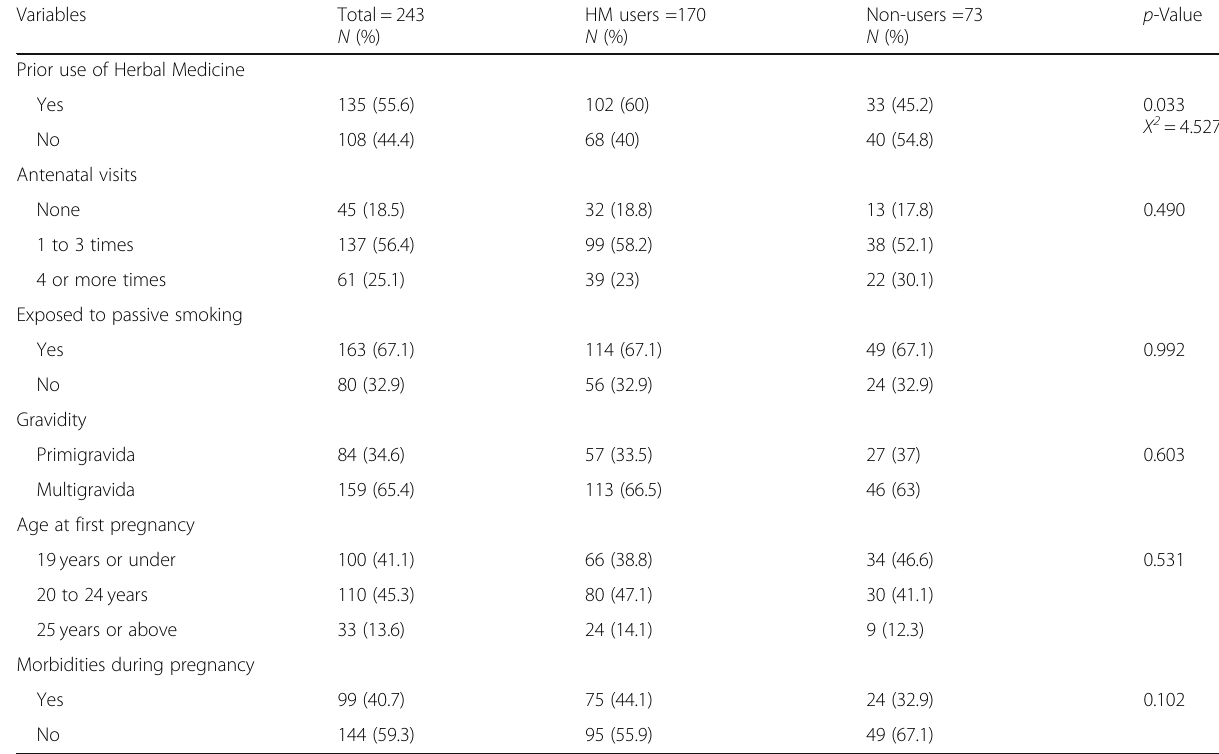
Table 2 Medical characteristics of